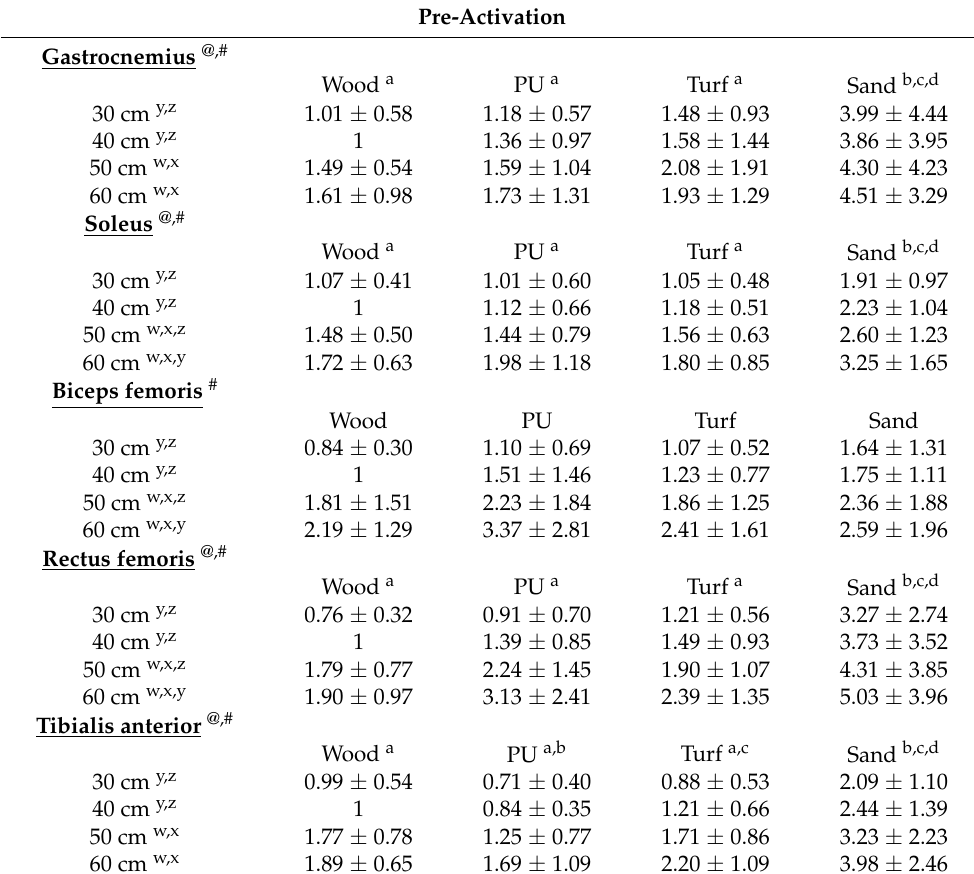
Table 1. Comparisons of normalized EMG 100 ms before ground